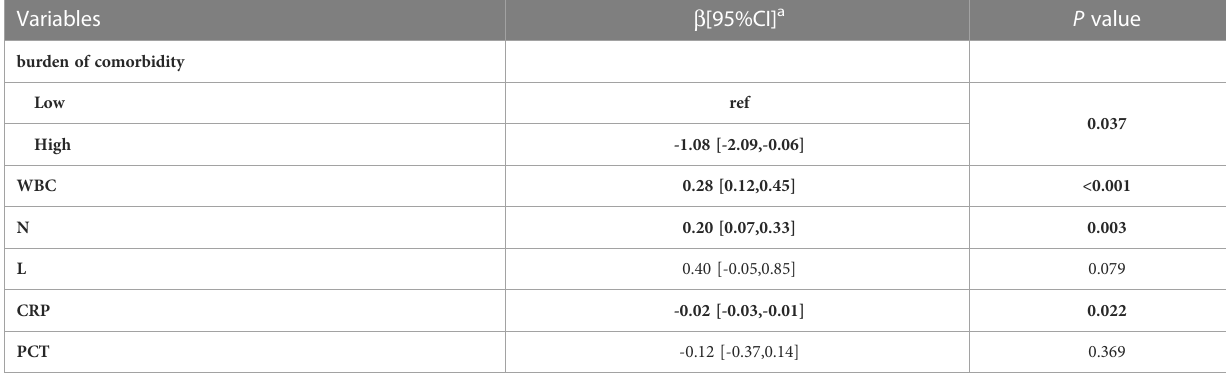
TABLE 3 Associations between in fl ammatory indicators and Ct values. Variables